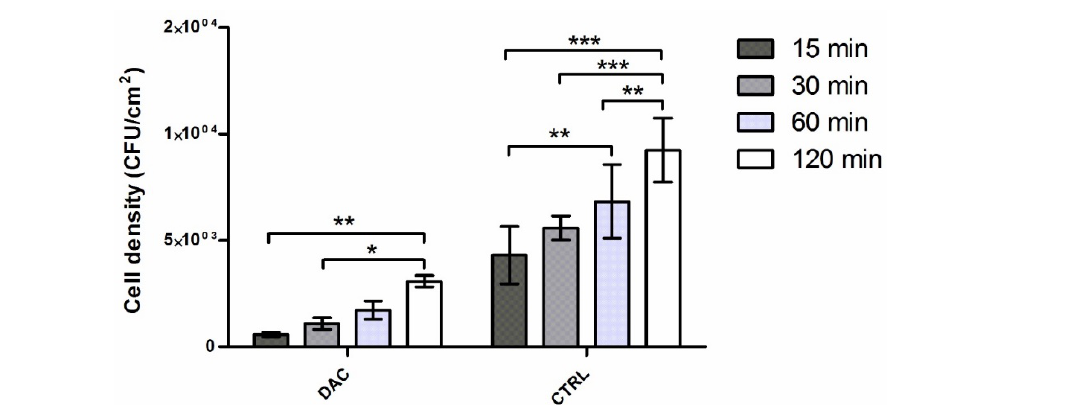
Figure 2. Adhesion densities of S. aureus ( mean CFU/cm 2 ± standard deviation ) to discs pre-treated with DAC ® (“Defensive Antibacterial Coating”, Novagenit Srl, Mezzolombardo, Italy) and controls at 15, 30, 60 and 120 min; *** P < 0.001 (two-way ANOVA followed by Bonferroni post hoc test).